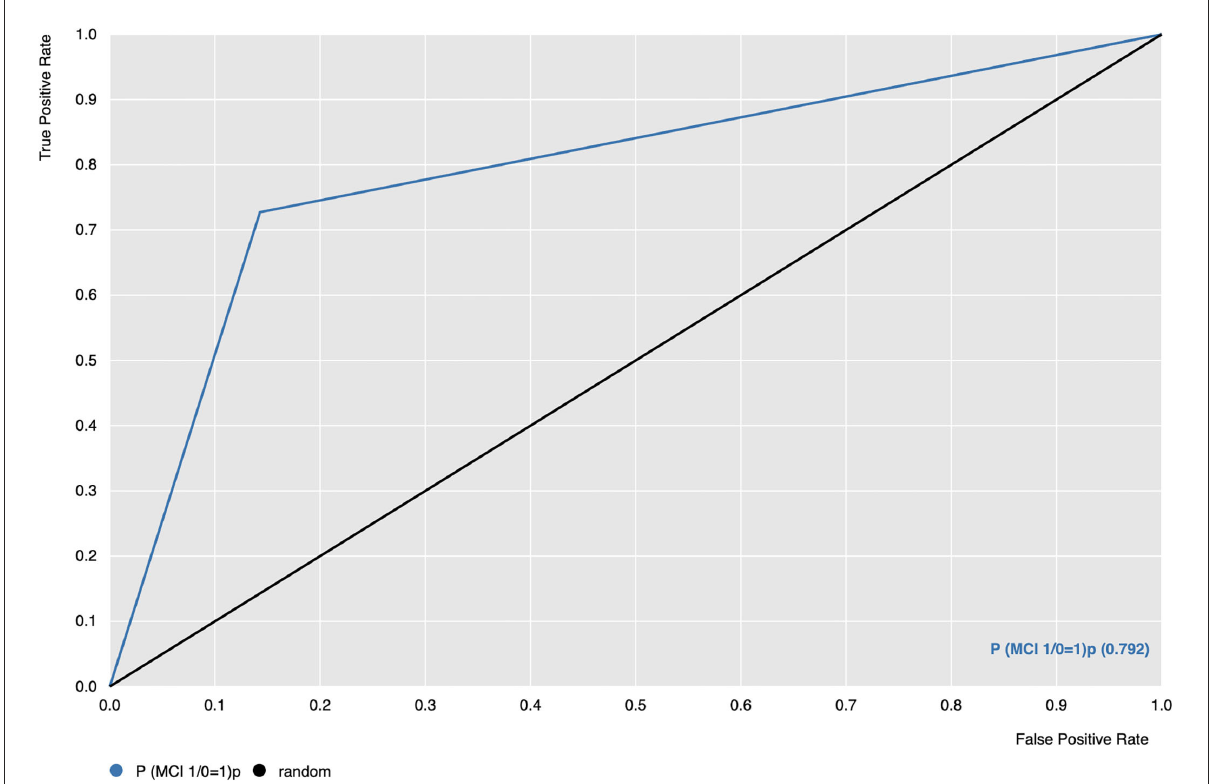
FIGURE1 Receiver Operating Characteristic (ROC) curve of SVM algorithm (blue line); ROC = 0.5, threshold for considering the model better than random guessing (black line). P(MCI 1/0 = 1) (orange line) is the probability of the model correctly classifying group 1, which corresponds to PD-MCI